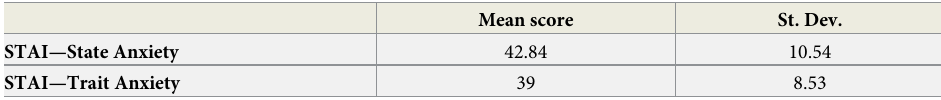
Table 3. Mean score and standard deviation for the State-Trait Anxiety Inventory.